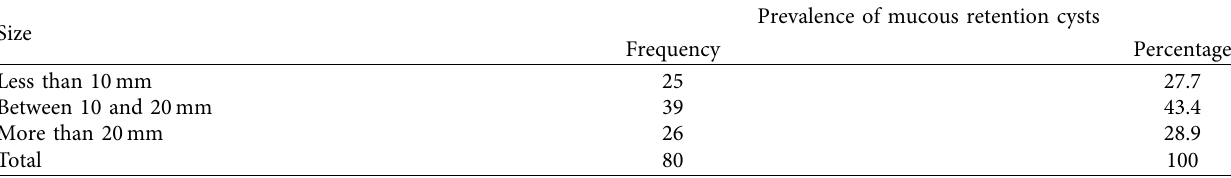
Table 5: The frequency of mucous retention cysts (MRCs) in the population was studied based on size.